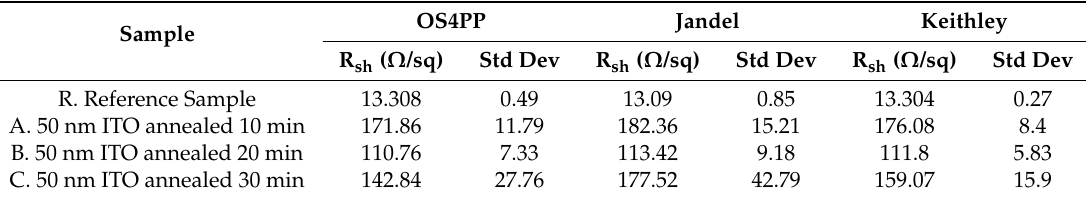
Table 1. Measurement results of several indium tin oxide (ITO) samples on different equipment. OS4PP Jandel Keithley Sample R sh ( Ω /sq) Std